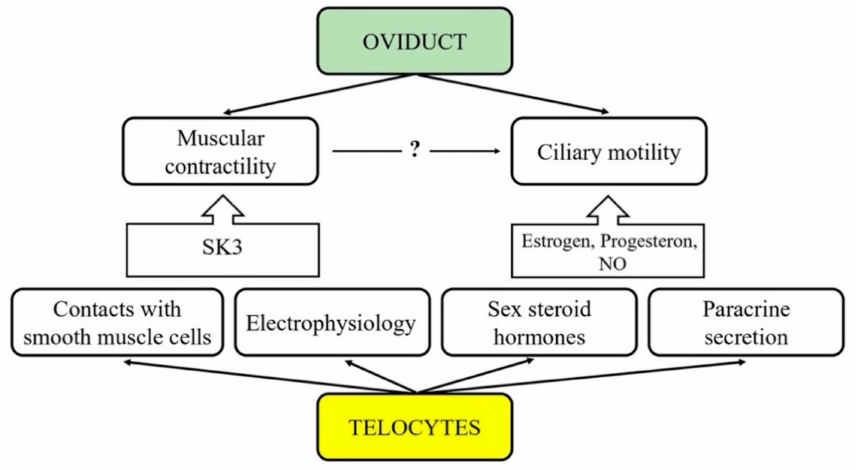
Figure 1. Interactions between telocytes and primary physiological processes within Fallopian